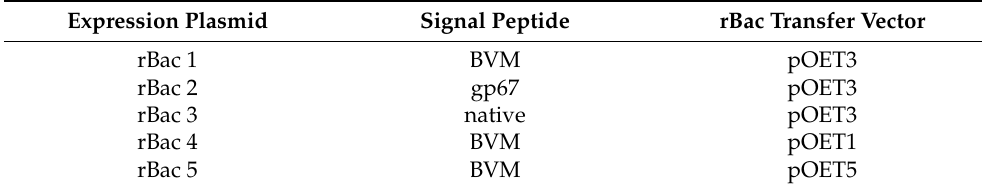
Table 1. List of expression plasmids used for baculovirus generation. Expression Plasmid Signal Peptide rBac Transfer Vector rBac